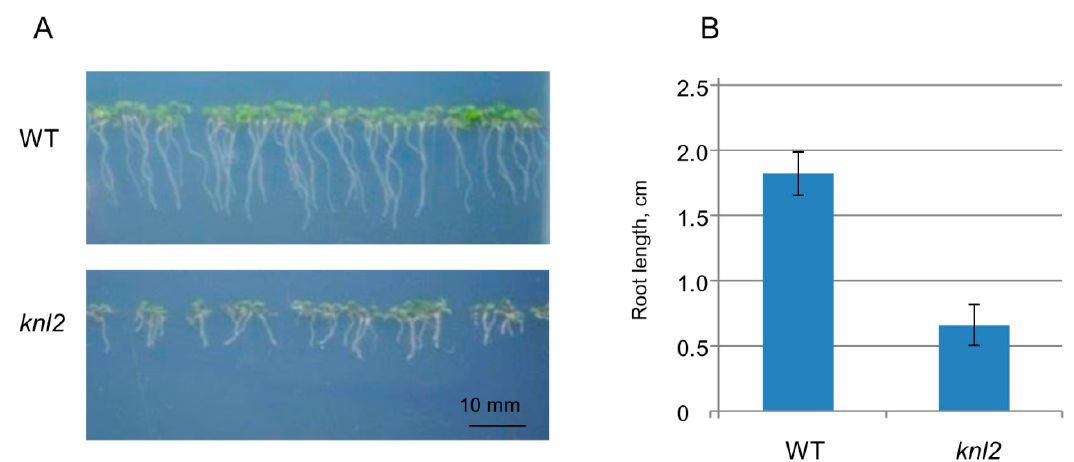
Figure 3. E ff ect of KNL2 depletion on the root development. ( A ) Representative phenotypes of wild-type (WT) and knl2 plants germinated and grown for seven days on 1 (MS) medium. Bar = 10 mm. ( B ) Quantitative data for plants described in ( A ). Data are the means ± standard errors, n = 20. Student’s t -test, p <